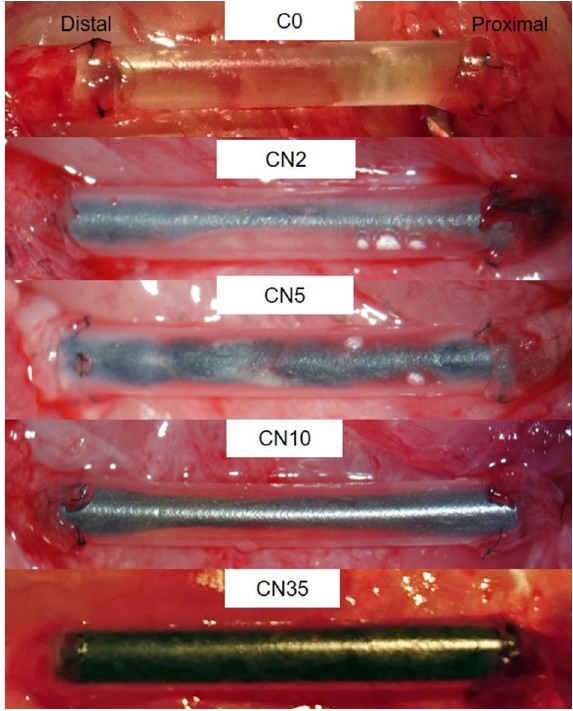
Figure 2. Intraoperative photographs showing the macroscopic appearance of the regenerated tissue along with the carbon nanotube yarns eight weeks after transplantation.